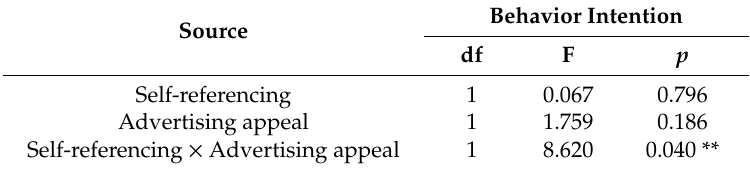
Table 2. ANOVA results of self-reference and advertising appeal on behavior intention.